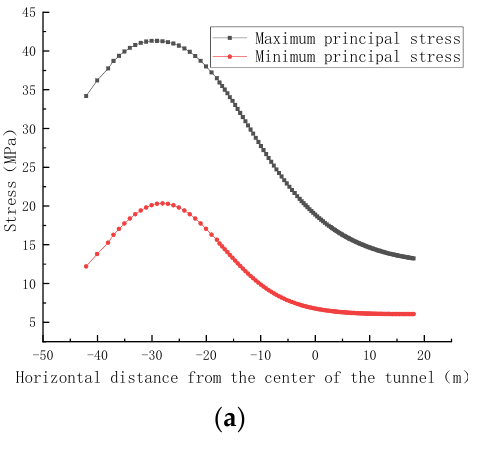
Figure 13. Changes in the principal stresses of the roadway’s surrounding rock when the roadway excavation along the floor. ( a ) Horizontal direction. ( b ) Variation direction.